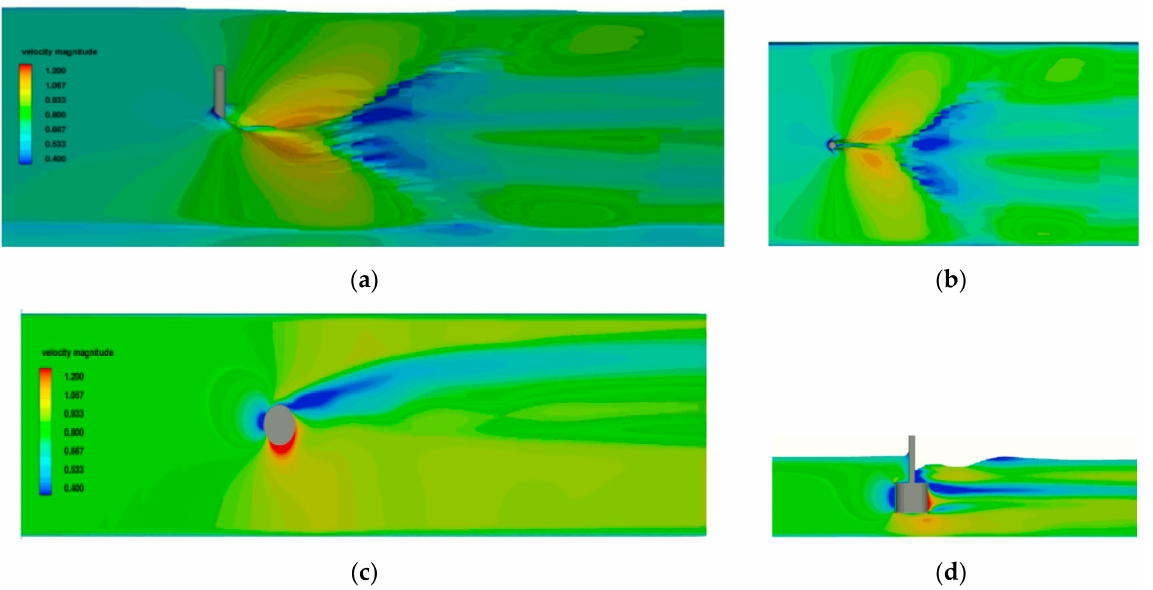
Figure 14. Results of 3D flow simulation for V = 0.82 m/s: ( a ) perspective view of velocity field on the free surface, ( b ) top view of velocity field on the free surface, ( c ) velocity field in the horizontal plane at half-length section of the rotor, and ( d ) velocity field in the rotor symmetry plane.